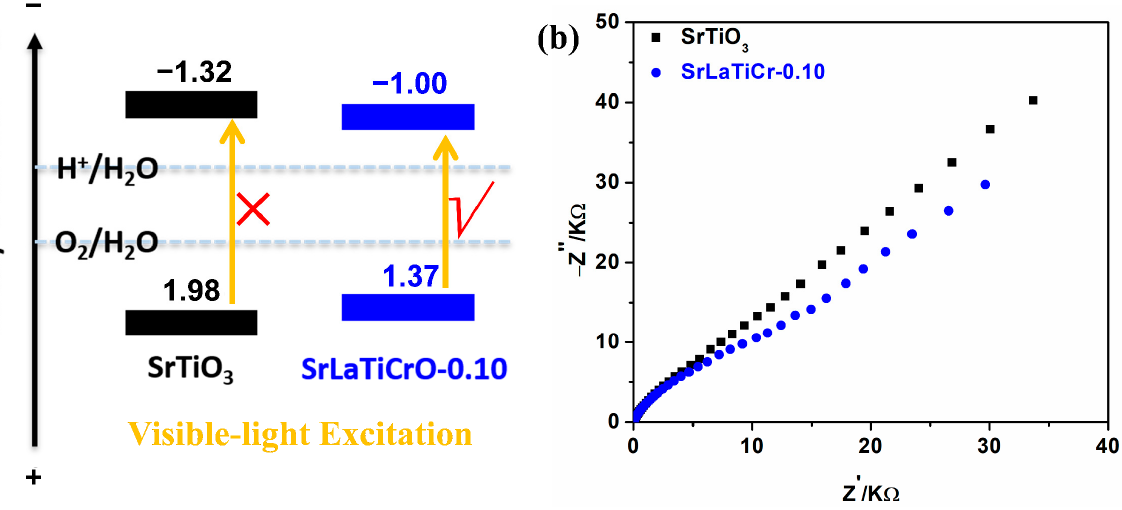
Figure 6. ( a ) Schematic illustration of the band structure of SrTiO 3 and SrLaTiCrO-0.10 with respect to photocatalytic hydrogen production under visible light irradiation. ( b ) EIS spectra of SrTiO 3 and SrLaTiCrO-0.10 photocatalysts.